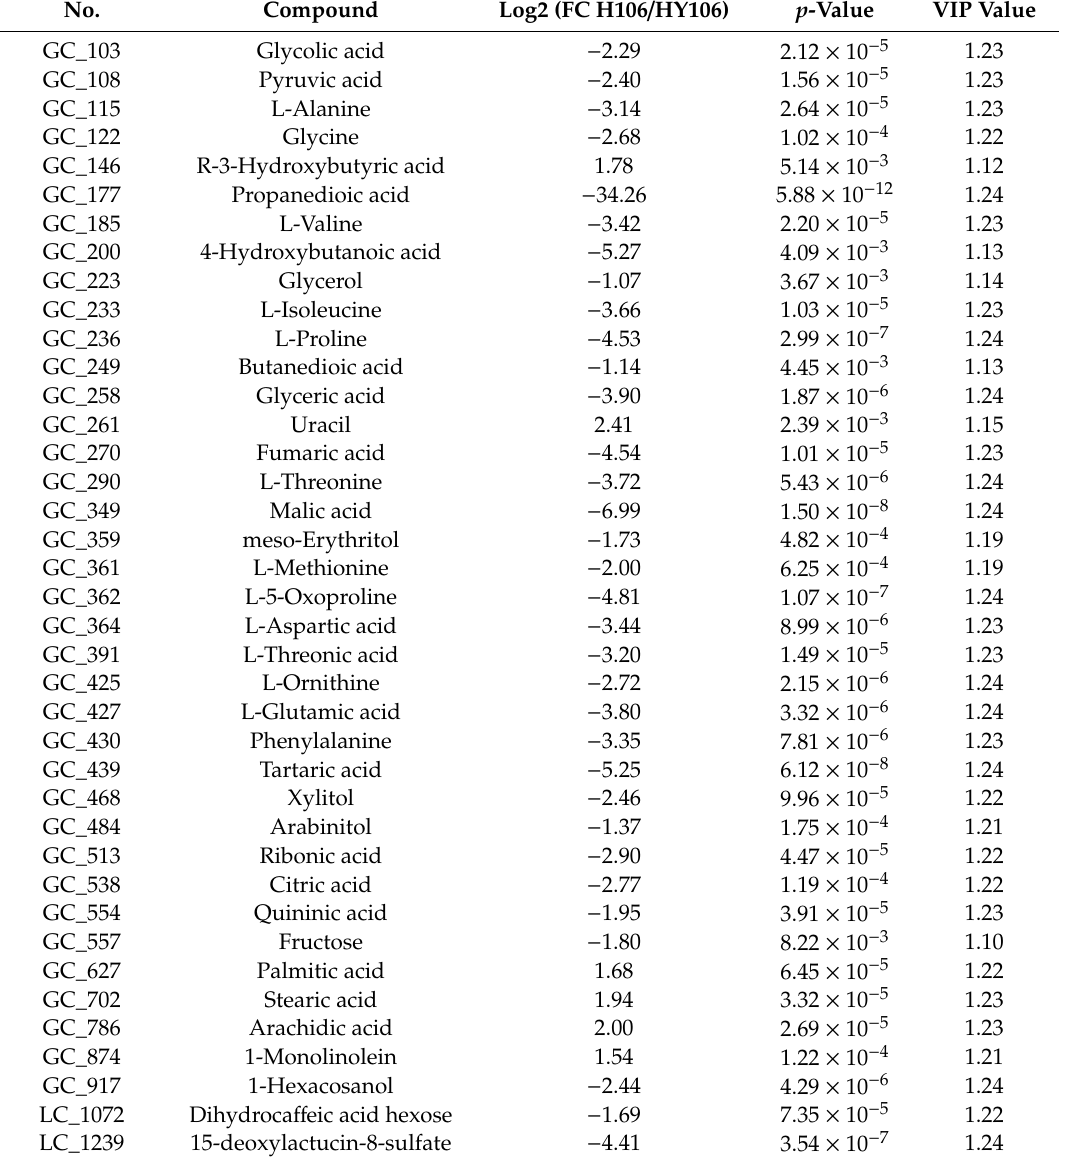
Table 4. Di ff erential metabolites between buds of S15k0106 germinated at 35 ◦ C (HY106) and seeds of S15k0106 that did not germinate at 35 ◦ C